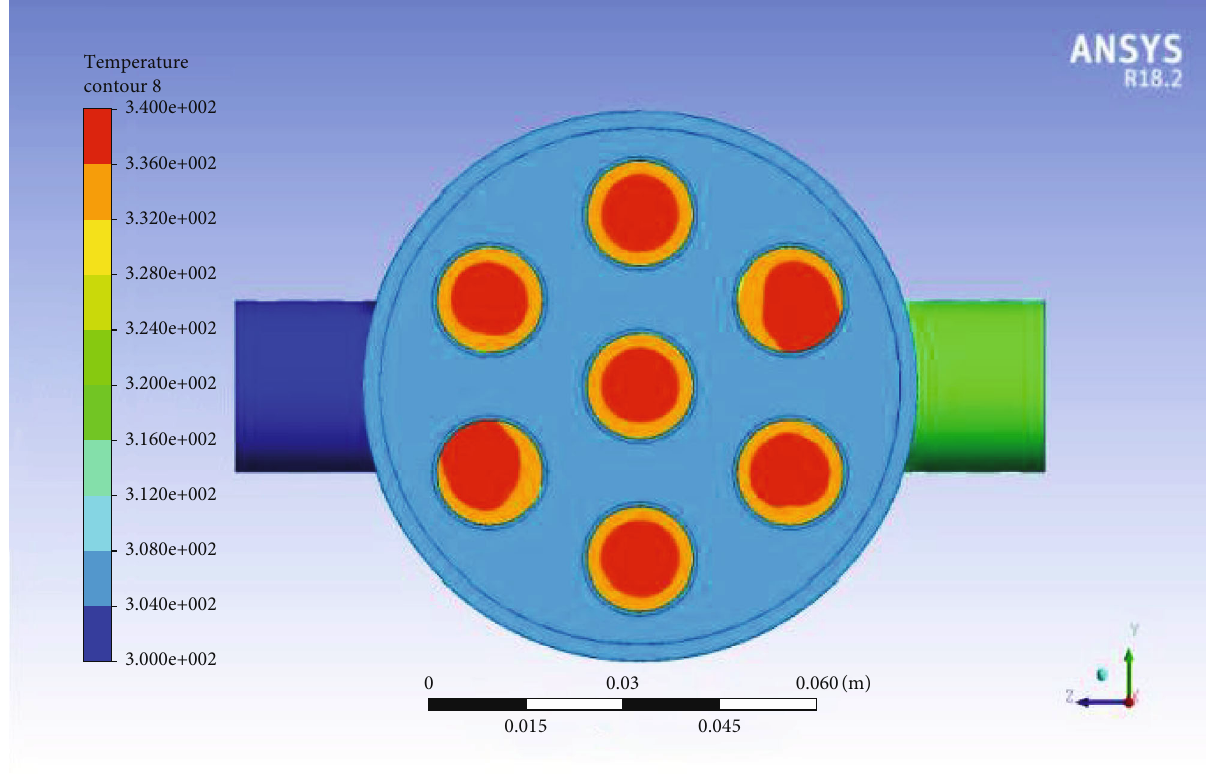
Figure 8: The temperature contour at outlet of cold fl uid.